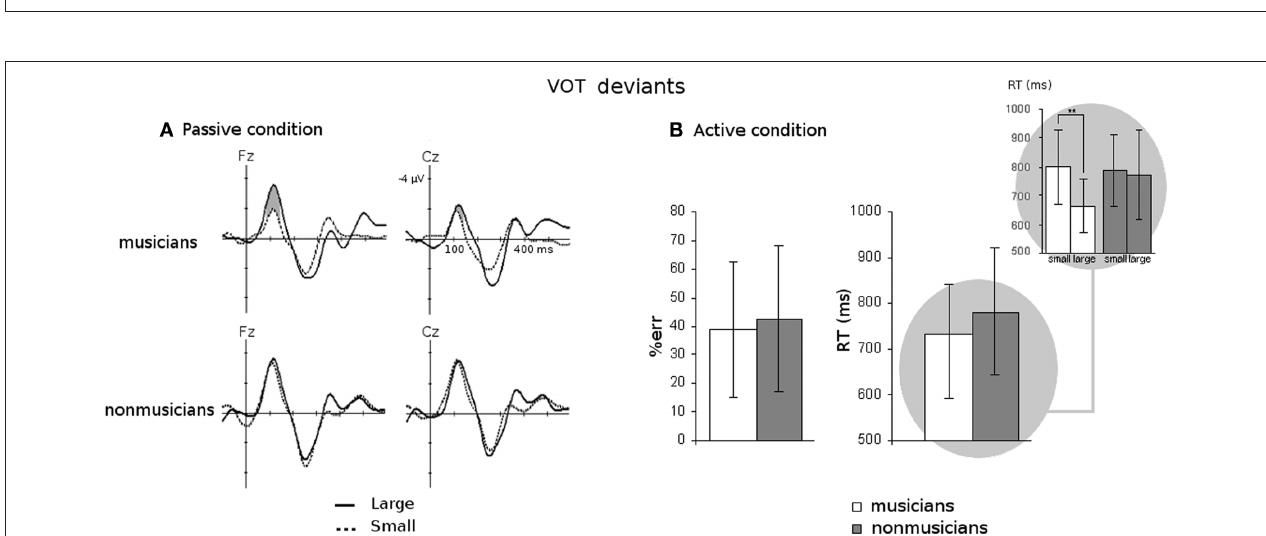
Figure 3 | (A) Mismatch negativity (MMN) elicited in musician and non-musician children (8 years old) passively listening to large and small duration deviants in speech sounds. In both cases, the MMN was larger in musician than in non-musician children thereby showing an influence of musical expertise on the pre-attentive processing of the duration of speech sounds. (B) Percentage of errors (%err) and reaction times